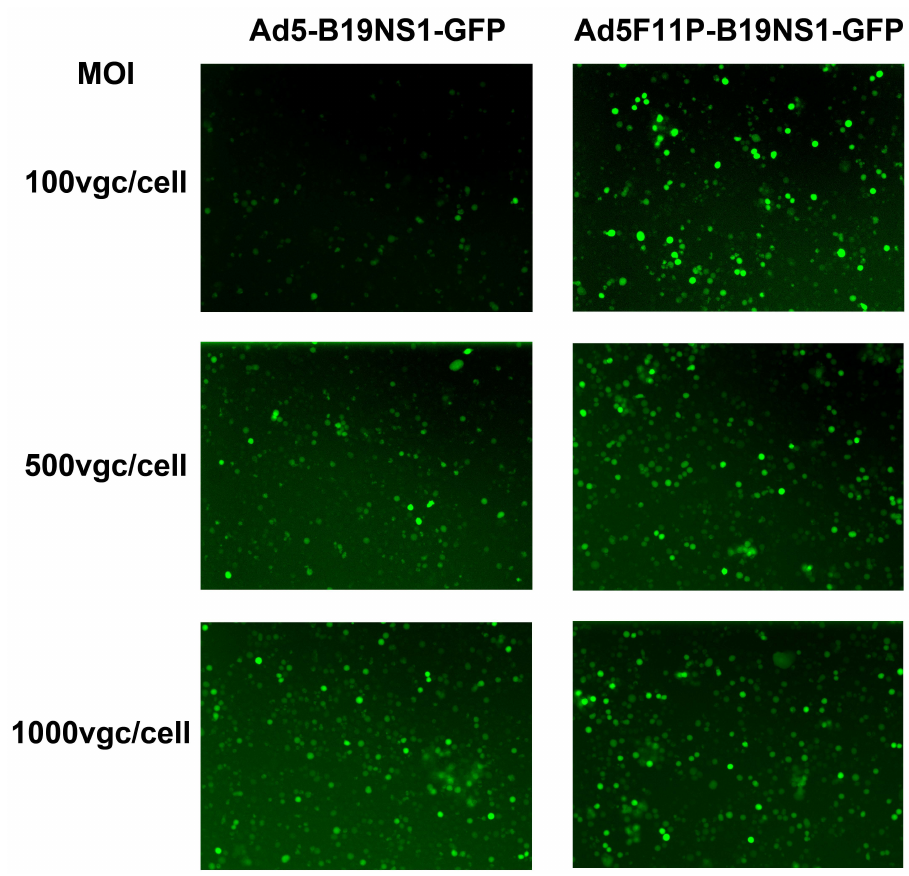
Figure 4. rAd5F11p-B19NS1-GFP is more e ff ective than the parent rAd5 in the transduction of leukemia cells UT7 / Epo-S1 at a relatively low MOI. UT7 / Epo-S1 cells were transduced with rAd5-B19NS1-GFP or rAd5F11p-B19NS1-GFP at three di ff erent MOIs (100, 500, and 1000 vgc / cell), respectively. At 48 h post-transduction, GFP expression was monitored under a Nikon Eclipse Ti-S inverted microscope at 10 ×